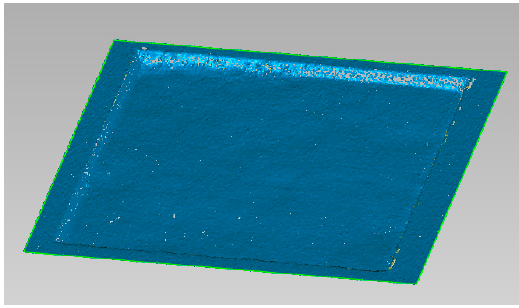
Figure 3. Example of point cloud.